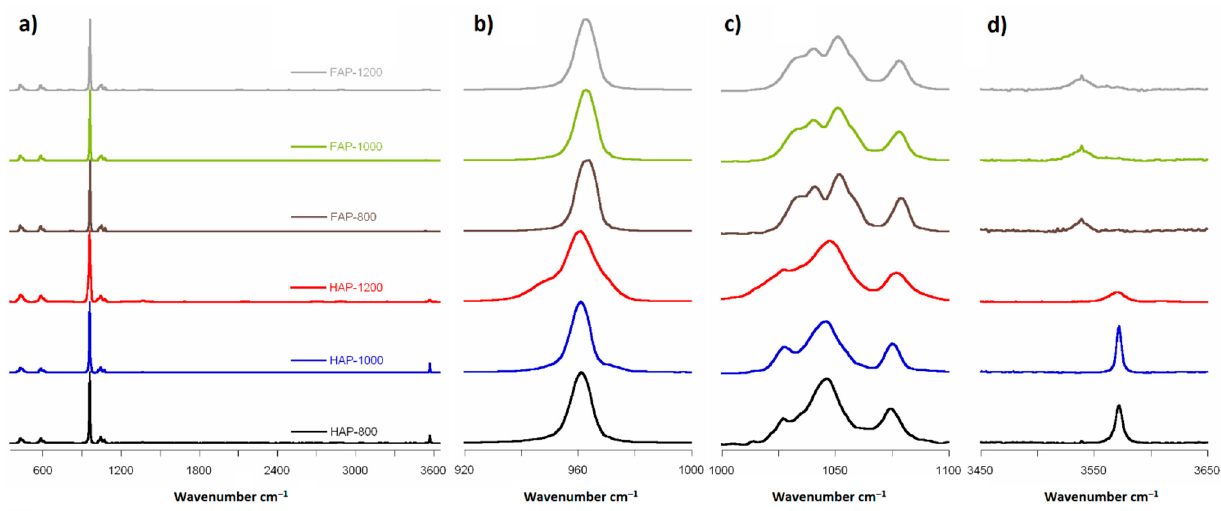
Figure 4. Raman spectra: ( a ) range 350 to 3600 cm − 1 ; ( b ) range 920 to 1000 cm − 1 ; ( c ) range 1000 to 1100 cm − 1 (magnified 10×); and ( d ) range 3450 to 3650 cm − 1 (magnified 20× for FAPs and 5× for HAPs).